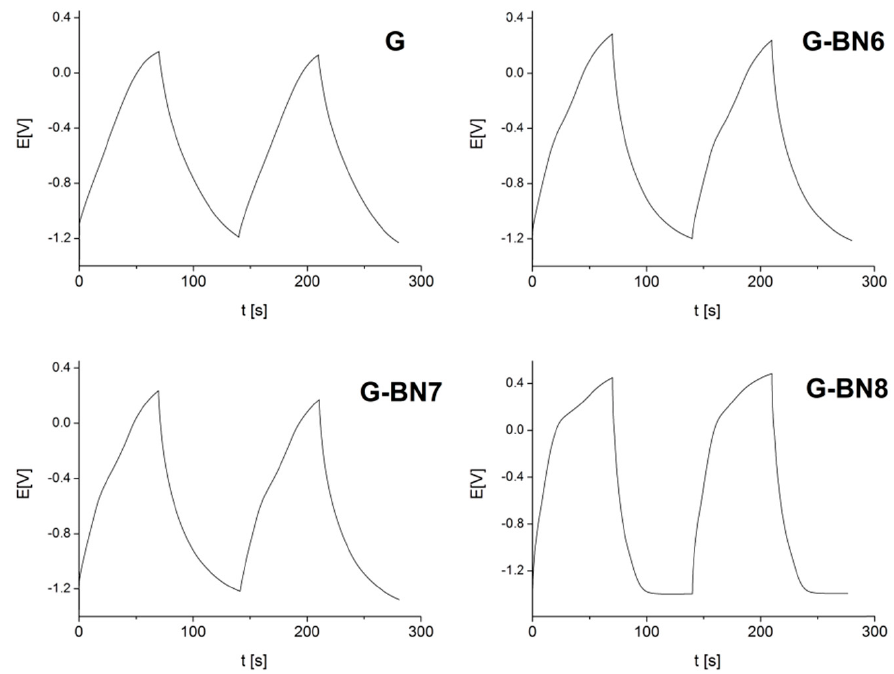
Figure 4. Galvanostatic charge-discharge curves registered for unmodified graphene ( G ) and graphene functionalized with fullerene derivatives BN6 , BN7 and BN8 , in 3M KOH at the current density of 1 A/g. Table 1. Specific capacitance of obtained electrode materials at the current density of 1 A/g. Sample